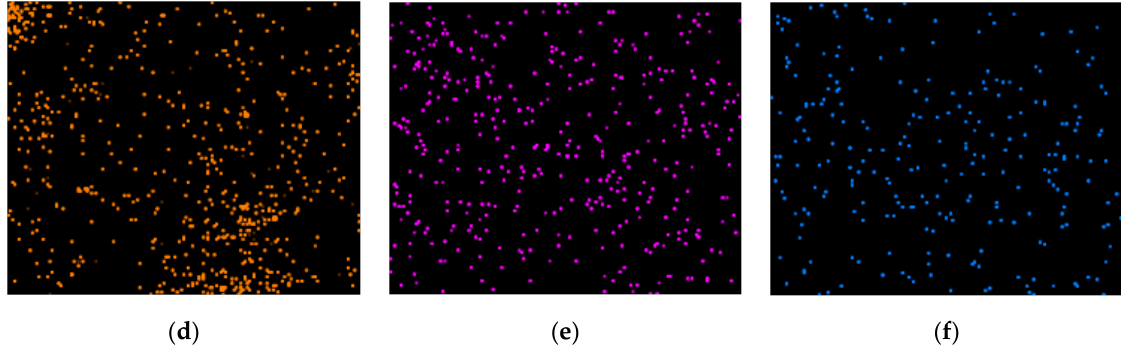
Figure 4. Distribution map of main elements in coal samples. ( a ) Carbonel element; ( b ) Oxygen element; ( c ) Aluminum element; ( d ) Silicon element; ( e ) Sulfur element; ( f ) Phosphorus element.